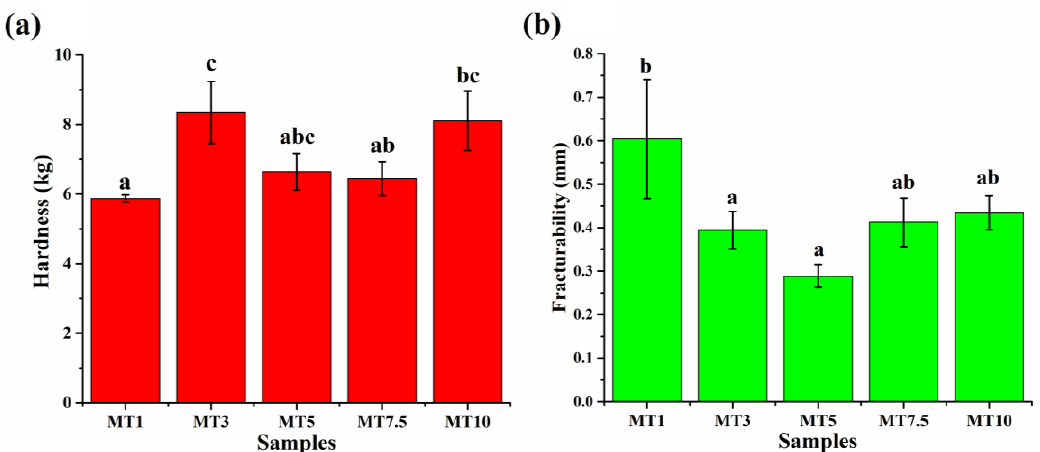
Figure 16. Bar plot of ( a ) hardness and ( b ) fracturability of WWF cookies prepared with different mixing times. Error bars represent the standard deviation of three replicates. Those not sharing the same letter(s) for each chart are significantly different by Tukey HSD test.